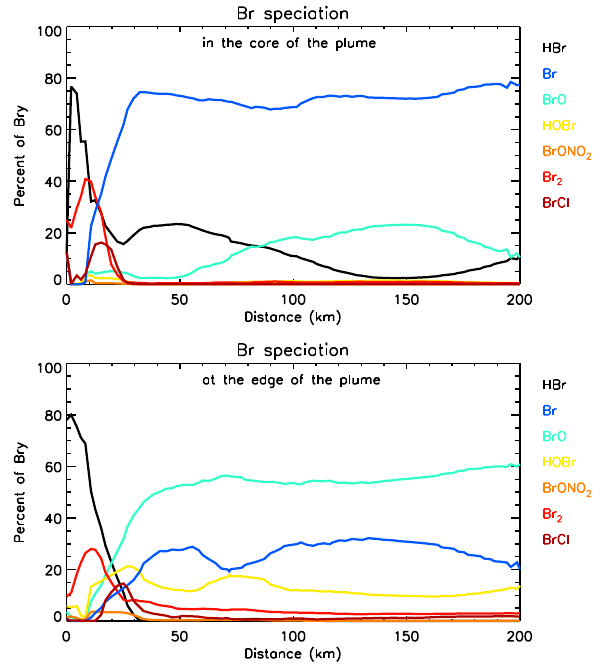
Figure 9. Br speciation along the plume (in the core and at the edge) in the simulation S1_HighT and the 2km × 2km grid for the 12 January 2005 at 06:00UTC. The Br speciation has been calculated as the percent of Br y (Br y = HBr + 2Br 2 + BrCl + Br + BrO + HOBr + BrONO 2 ) . Distance is calculated from the middle of the grid box containing Marum and